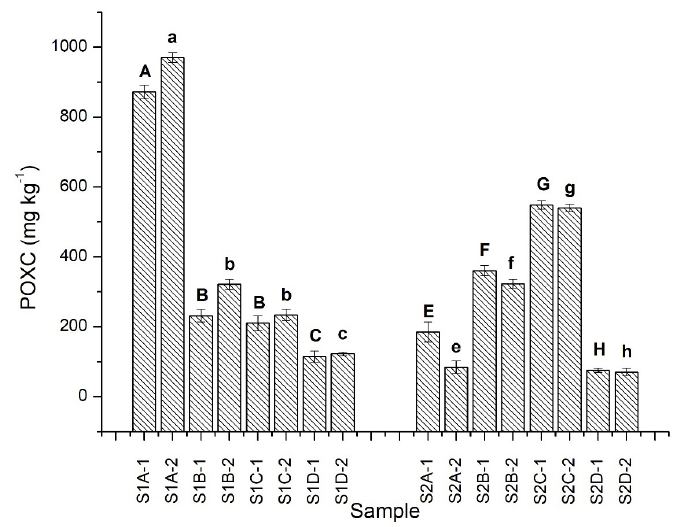
Figure 5. Permanganate-oxidizable carbon (POXC) in the studied soils. S1: soil from the limestone open-cast mining remediated with embankment; S2: soil from the lignite open-cast mining remediated with sewage sludge; subsequent letters A–D mean different remediated areas located at the same mine; subsequent numbers mean different sampling periods; 1: spring 2021, 2: spring 2022. Mean values ± SD, n = 3. Different letters above the columns indicate significant differences between tested treatments ( p < 0.05) according to Tukey’s test. Small and large letters indicate separate analyses for both sampling soils.